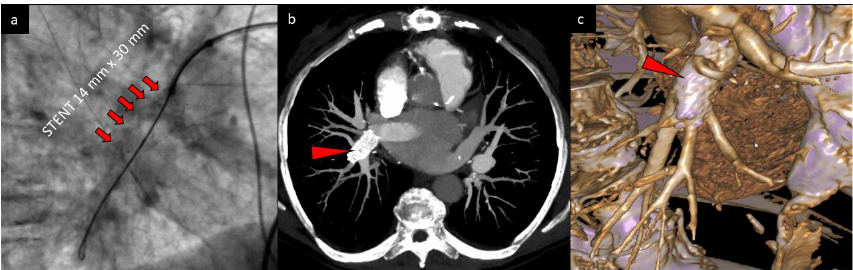
Figure 4. The final result of BPA and stent implantation (marked by red arrows) presented in fluoroscopy ( a ), computed tomography ( b ), and 3D reconstruction ( c ).